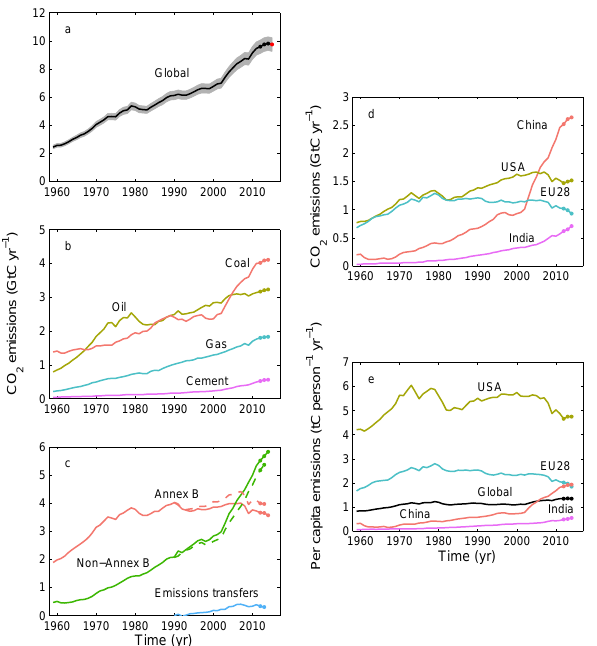
Figure 5. CO 2 emissions from fossil fuels and industry for (a) the globe, including an uncertainty of ± 5% (grey shading), the emis- sions extrapolated using BP energy statistics (black dots), and the emissions projection for year 2015 based on GDP projection (red dot); (b) global emissions by fuel type, including coal (salmon), oil (olive), gas (turquoise), and cement (purple), and excluding gas flaring, which is small (0.6% in 2013); (c) territorial (full line) and consumption (dashed line) emissions for the countries listed in the Annex B of the Kyoto Protocol (salmon lines; mostly advanced economies with emissions limitations) versus non-Annex B coun- tries (green lines) – also shown are the emissions transfers from non-Annex B to Annex B countries (light-blue line); (d) territo- rial CO 2 emissions for the top three country emitters (USA – olive; China – salmon; India – purple) and for the European Union (EU28, the 28 member states of the EU in 2012 – turquoise), and (e) per- capita emissions for the top three country emitters and the EU (all colours as in panel d ) and the world (black). In panels (b) to (e) , the dots show the preliminary data that were extrapolated from BP energy statistics for 2012, 2013, and 2014. All time series are in GtC yr − 1 except the per-capita emissions (panel e ), which are in tonnes of carbon per person per year (tCperson − 1 yr − 1 ). All territo- rial emissions are primarily from Boden et al. (2013) except national data for the USA and EU28 for 1990–2012, which are reported by the countries to the UNFCCC as detailed in the text; consumption- based emissions are updated from Peters et al.